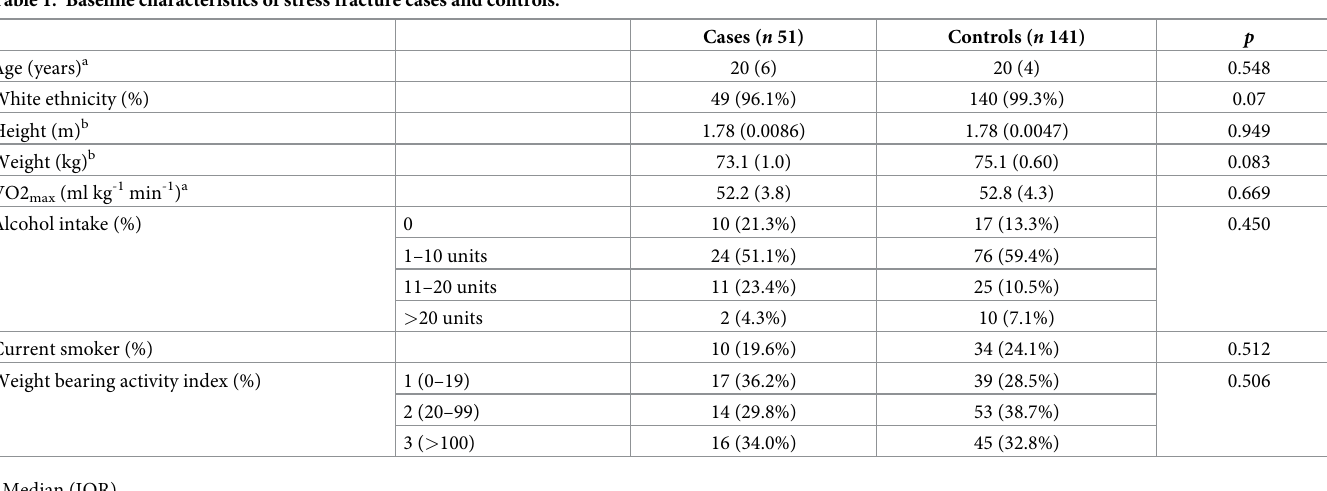
Table 1. Baseline characteristics of stress fracture cases and